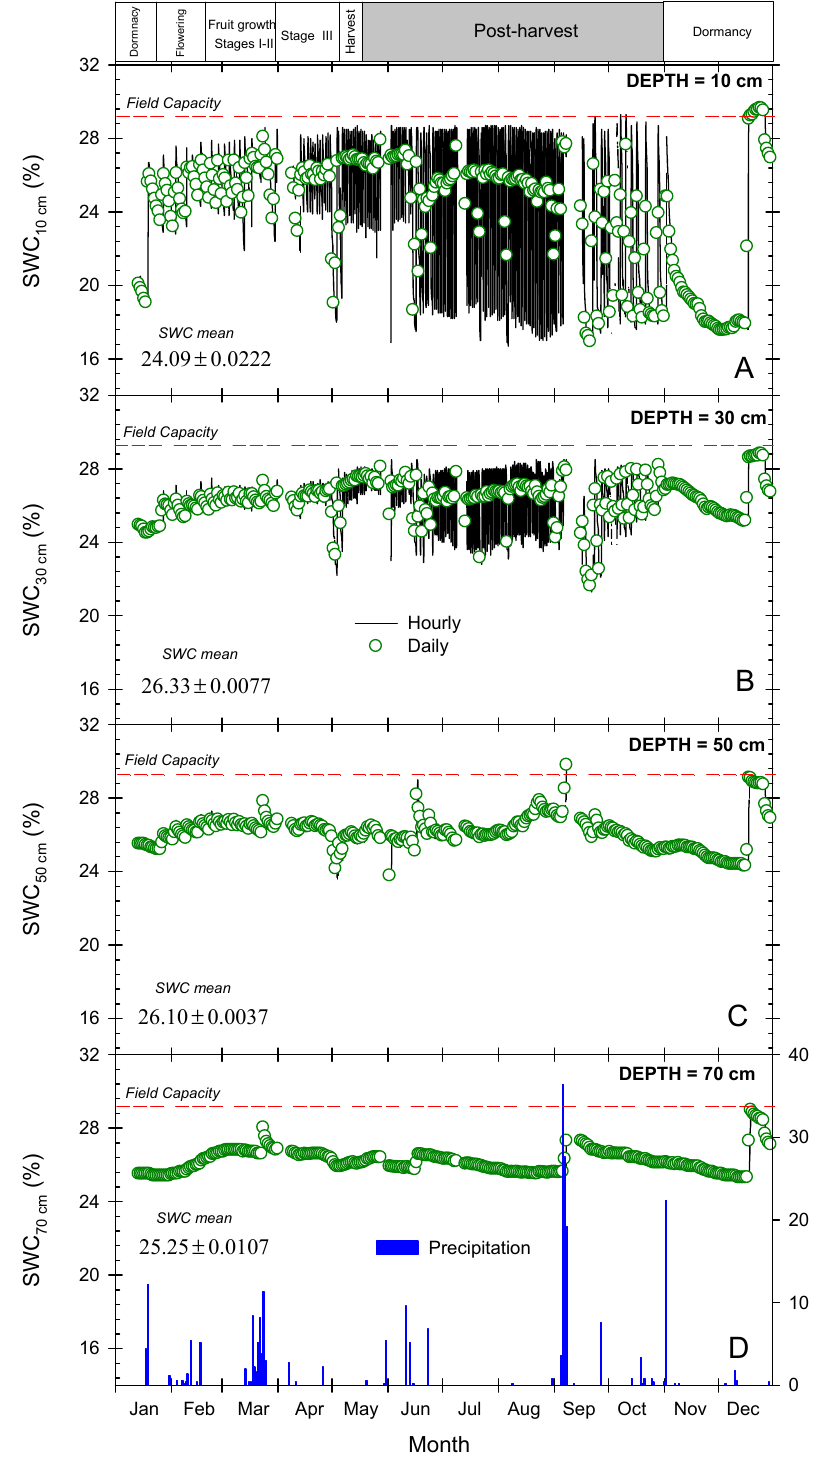
Figure 2. Soil water content (SWC, %) during the studied period at 10 cm ( A ), 30 cm ( B ), 50 cm ( C ), 70 cm ( D ) depth in the soil profile as 15 min recorded values (black line) and computed daily means ( symbols). Vertical bars indicate the daily precipitation values ( D ). Horizontal bar delimits field (cid:35) capacity. Each point is the mean of four sensors. Phenological stages for nectarine trees are depicted in the top